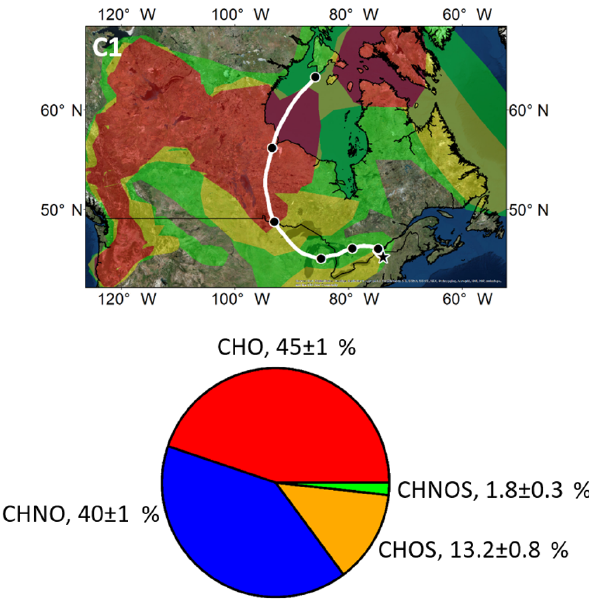
Figure 4. NOAA HYSPLIT 144h (6-day) backward air mass tra- jectory (white line, with 1-day resolution, shown as black dots) and corresponding cloud water molecular composition, shown as compound-type number fractions during the wildfire event (sam- ple C1). Green, yellow, and red shading on the map represents low, moderate, and high amounts of smoke, respectively, as defined by the NOAA Hazard Mapping System Fire and Smoke Product